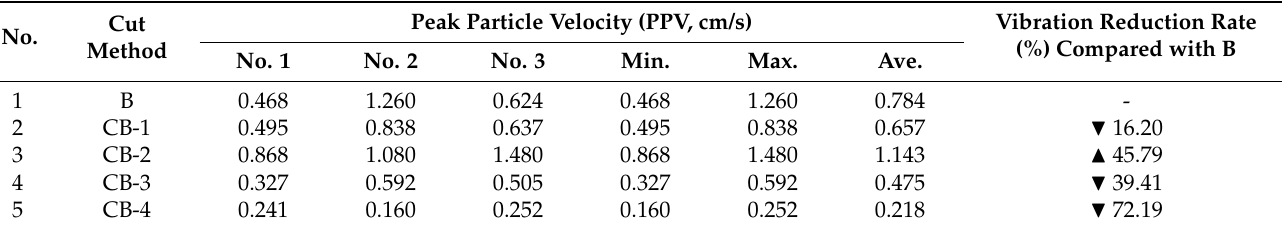
Table 5. Measured results of blast-induced